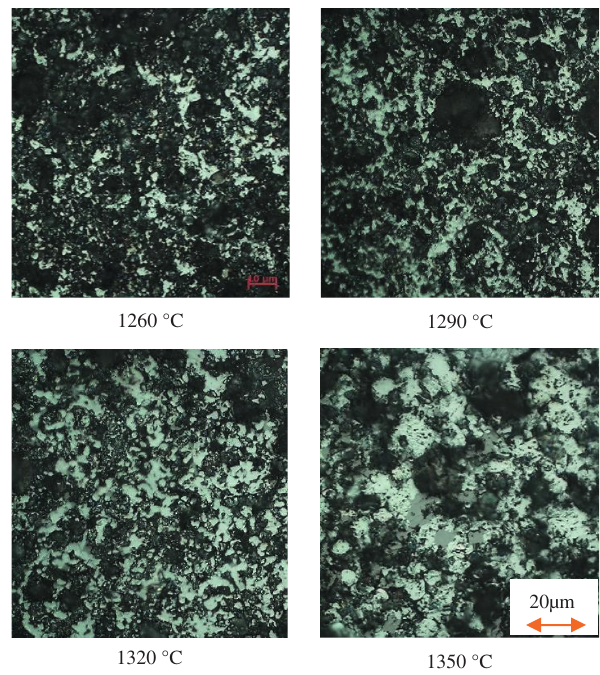
Figure 7: Microstructure of roasted pellets (white, ferric